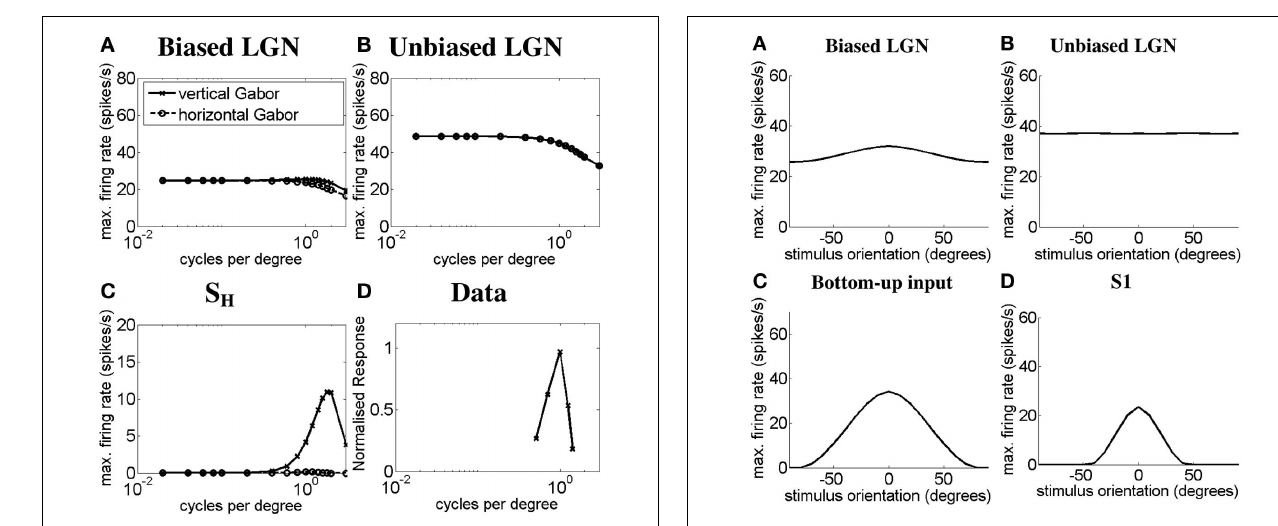
FIGURE 5 | Spatial frequency-response function of the simple-like hypercomplex cell. The plots show simulated SF-response functions of (A) an ON LGN cell with a vertically biased center and a strong isotropic inhibitory surround, (B) an ON LGN cell with an isotropic center and a weak isotropic inhibitory surround, and (C) the corresponding vertically oriented simple-like hypercomplex cell in response to a vertical Gabor patch (solid lines) and a horizontal Gabor patch (dashed lines). (D) The SF-response function of a real simple-like hypercomplex cell in response to a Gabor patch of the preferred orientation (Data adapted from Kulikowski and Bishop, 1981). Axes are the same as in Figure 4 except in (D) the y -axis represents the normalized response to a grating stimulus of limited extent.